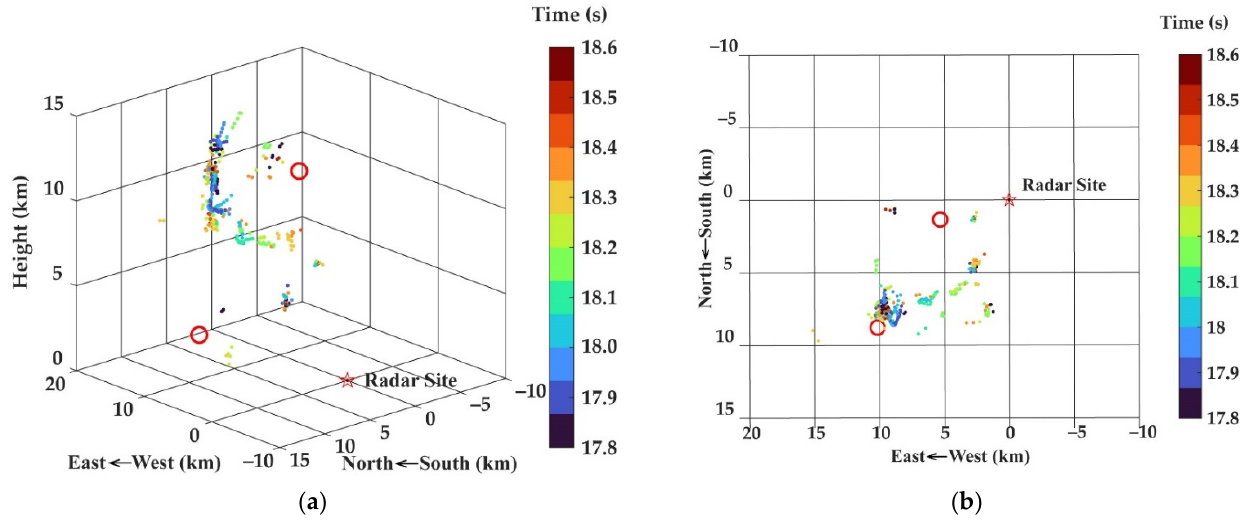
Figure 6. The 3D reconstruction and 2D project of the lightning channel. ( a ) The 3D locating result of the lightning channel, two VLF locating results (shown as two red circles), and the radar site (marked as a pentagram); ( b ) the projection of the 3D locating result at the top view. Table 2. VLF data records of two lightning cases.